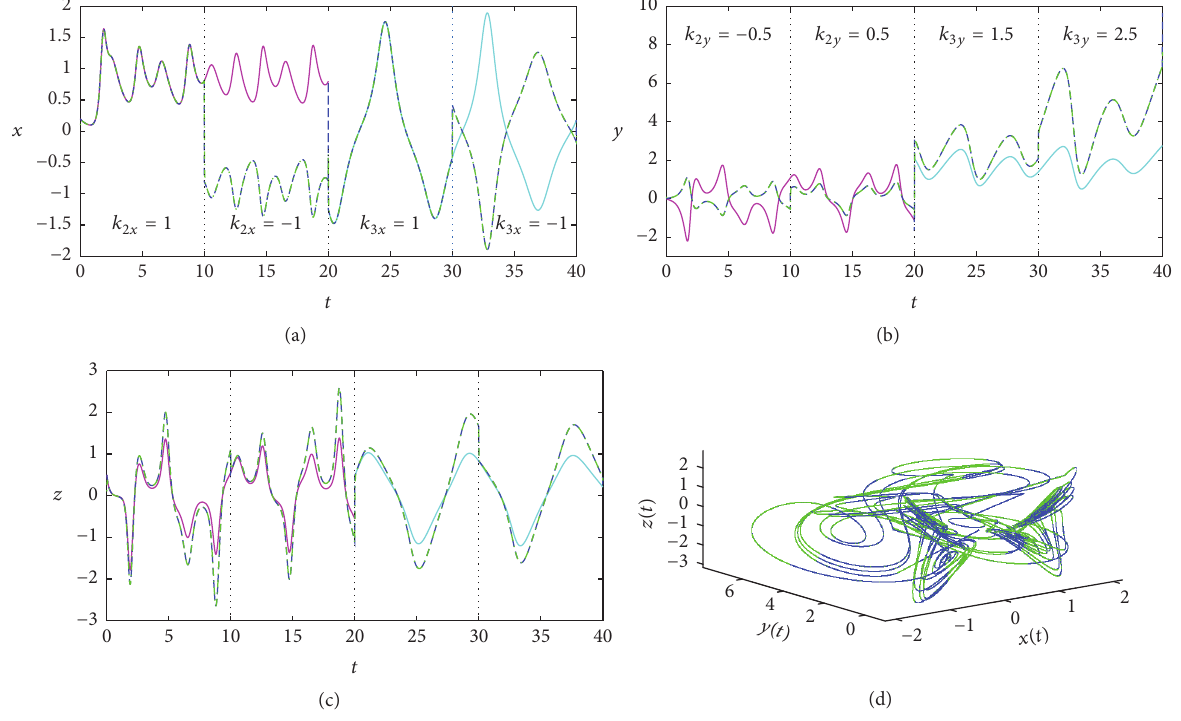
Figure 8: Dynamic switched synchronization with dynamic scaling factors: (a) 𝑥 time series, (b) 𝑦 time series, (c) 𝑧 time series, and (d) resulting master and slave systems successfully